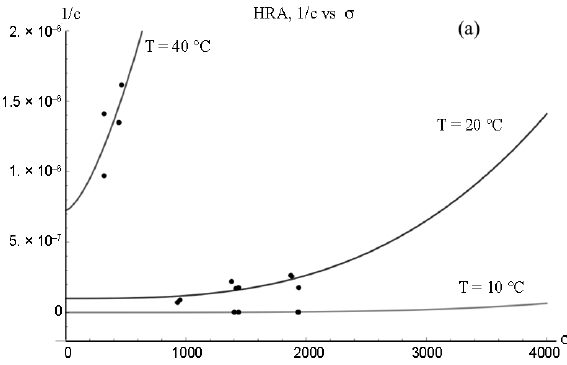
1.5Fig. 6. Experimental trend of 1/ c parameter at different temperatures Table 2. Coefficients in Eqn (12a,b) for HRA HRA